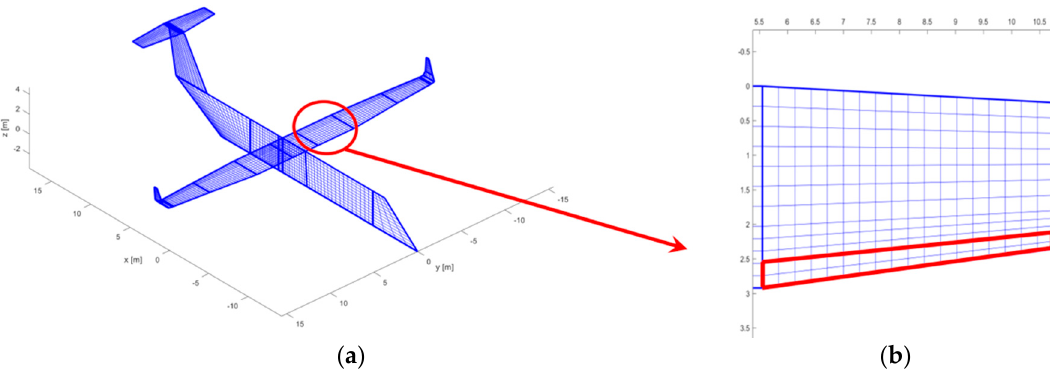
Figure 5. Aerodynamic model used for limit load evaluation by means of DLM: ( a ) Aerodynamic Lattice of the reference regional aircraft TP90; ( b ) aerodynamic lattice of the outboard wing trailing-edge.